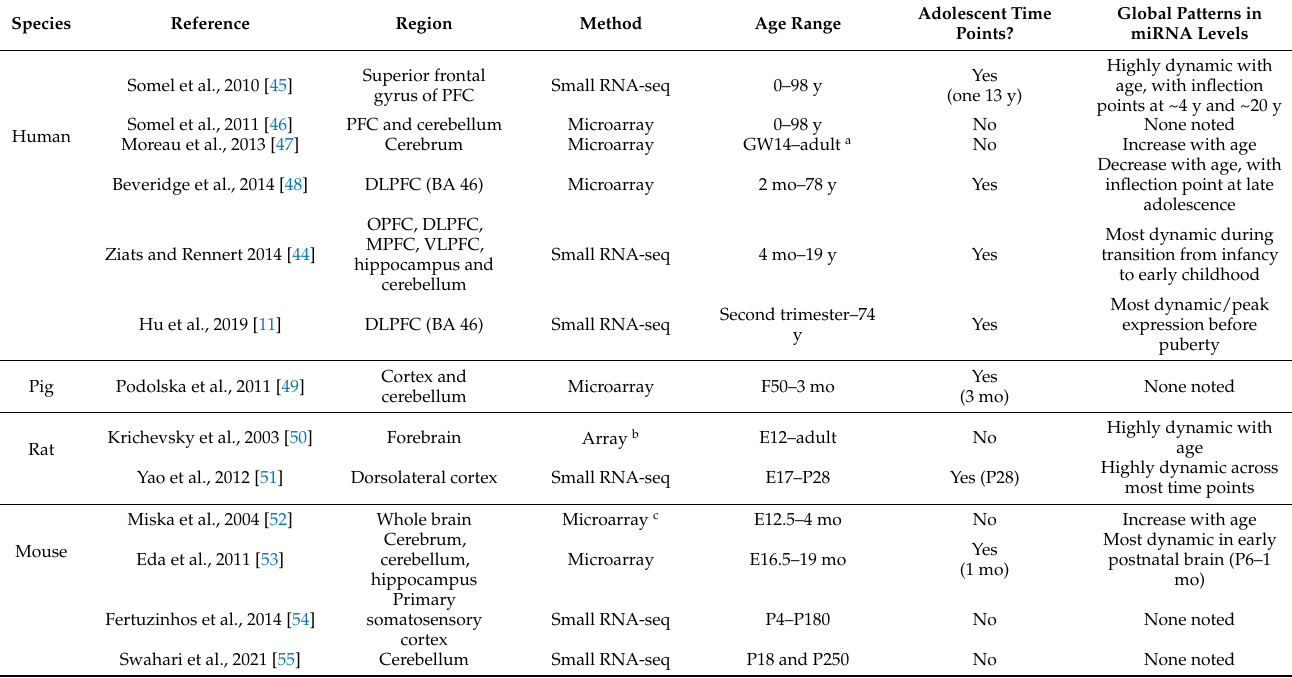
Table 1. Global patterns in miRNA levels with